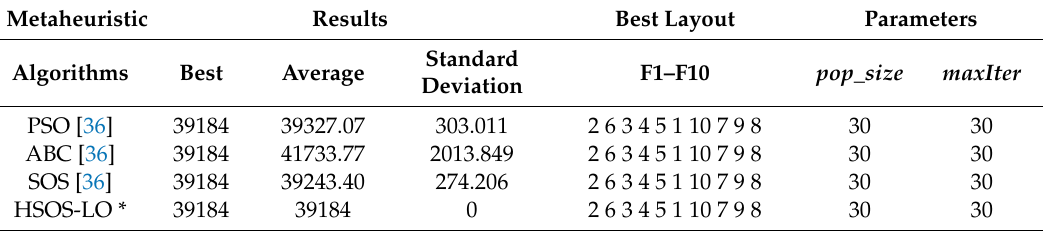
Table 9. Comparative results of DE, PSO, SOS, and HSOS-LO for Case 3. Metaheuristic Results Best Layout Parameters